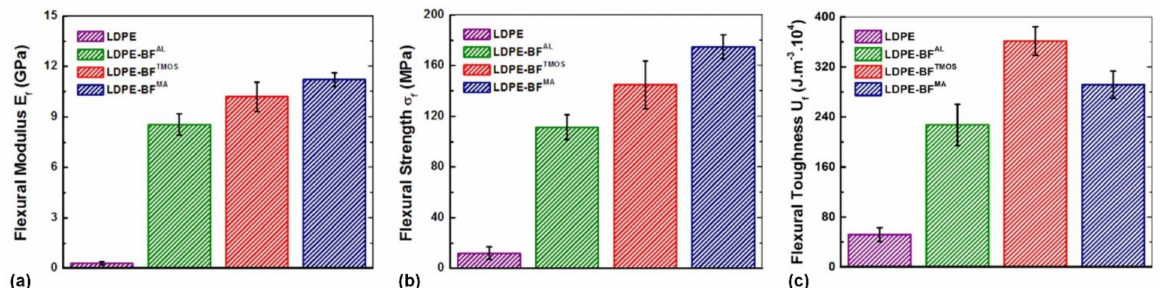
Figure 6. The influence of the alkaline treatment and TMOS and MA coupling agents on the ( a ) flexural modulus, ( b ) flexural strength and ( c ) flexural toughness compared to the neat